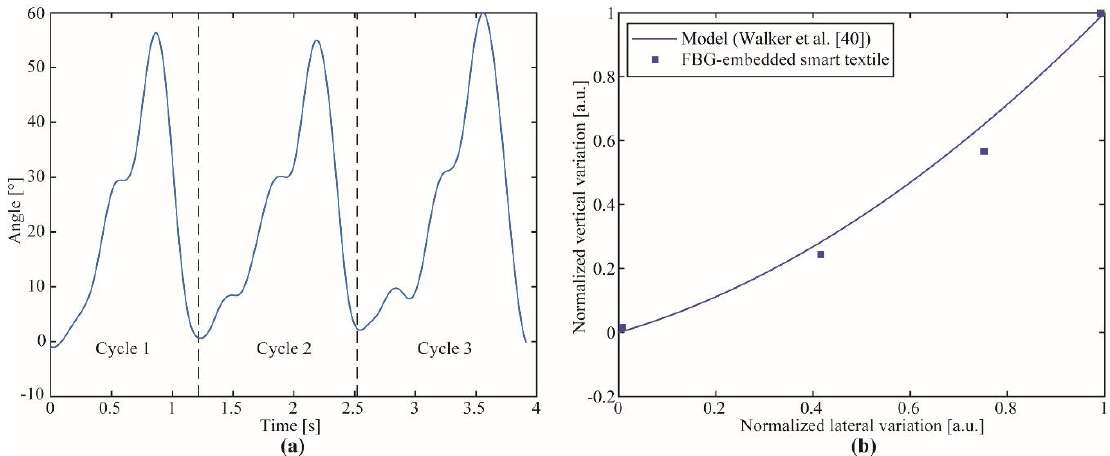
Figure 10. ( a ) Estimated angle using the FBG-embedded smart textile for gait tests. ( b ) Lateral and vertical displacements on the FBG for knee flexion cycles. The results are compared with the model presented in Walker et al. [45], which was derived from experimental measurements.